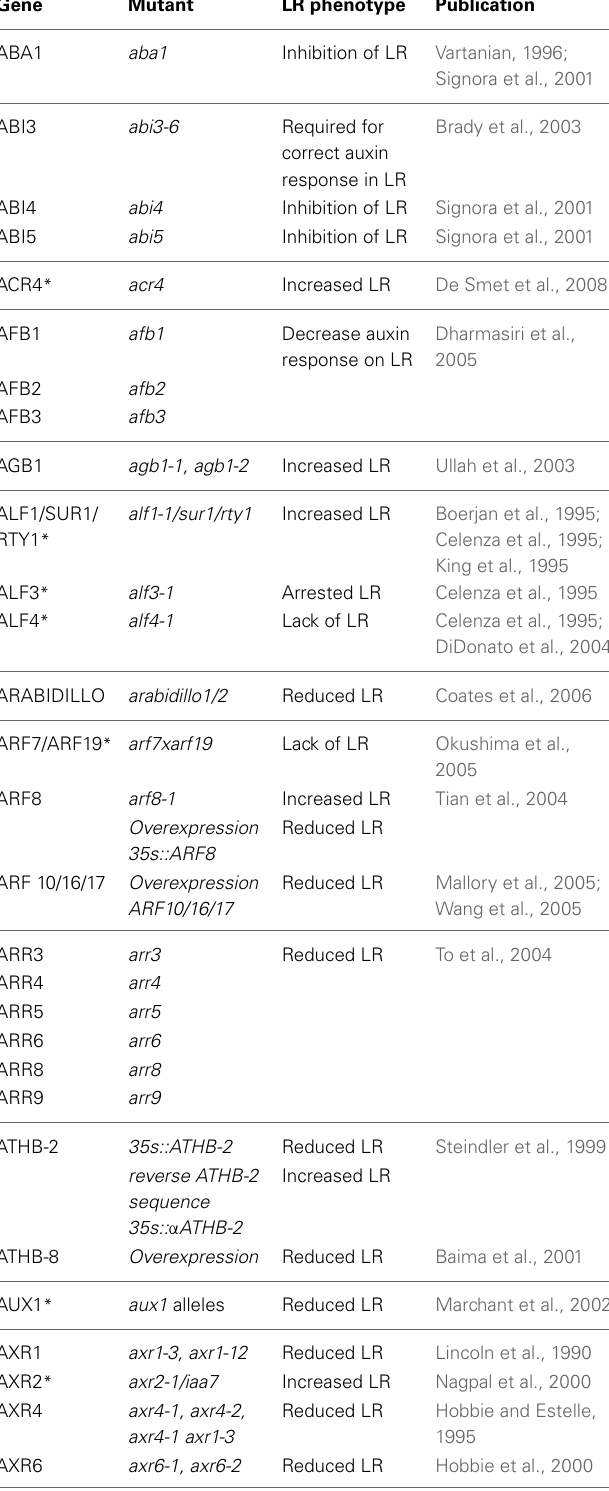
Table 1 | Summary of the genes involved in LR initiation and development, including those summarized in Casimiro et al. (2003), De Smet et al. (2006) and Péret et al.